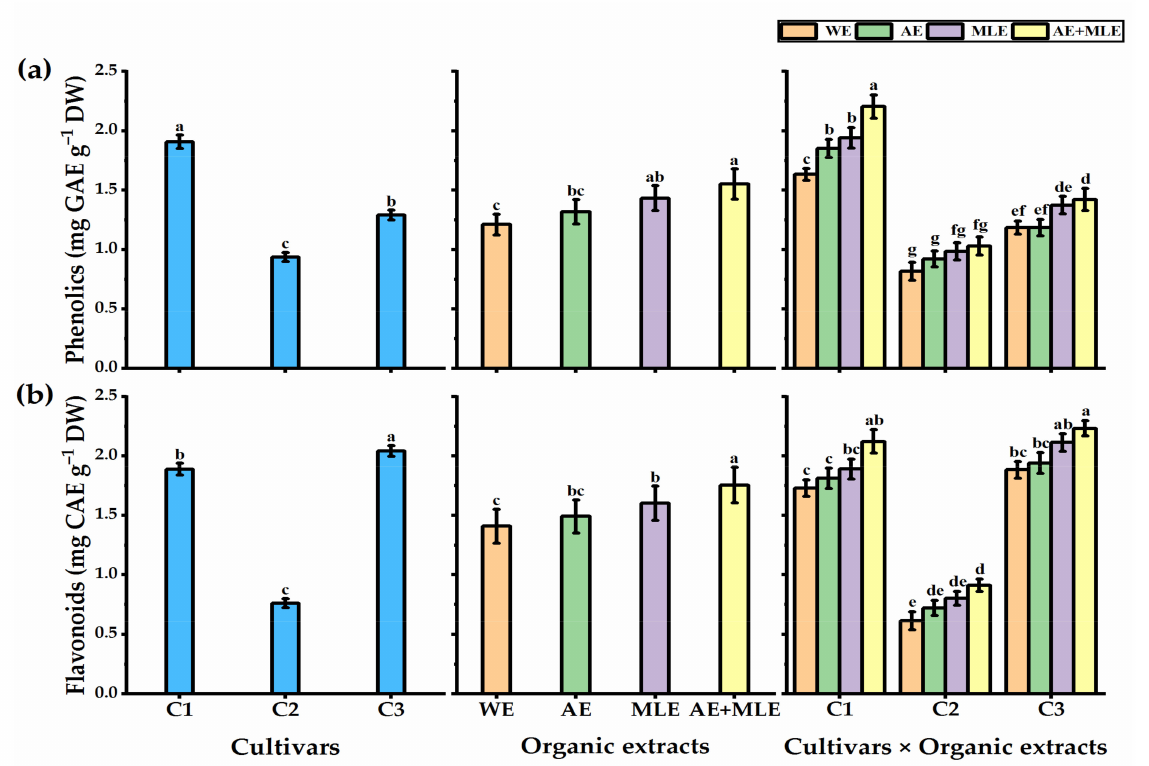
Figure 7. Effect of Azolla extract, moringa leaf extract, and their combination on ( a ) phenolics (mg GAE g − 1 DW), and ( b ) flavonoids (mg CAE g − 1 DW) of three quinoa cultivars. C1 = KVL − SRAZ, C2 = Chipaya, C3 = Q − 37, WE = without extract, AE = Azolla extract, MLE = moringa leaf extract. Data are mean value ± SE, n = 3. Different letters denote significant differences at p ≤ 0.05